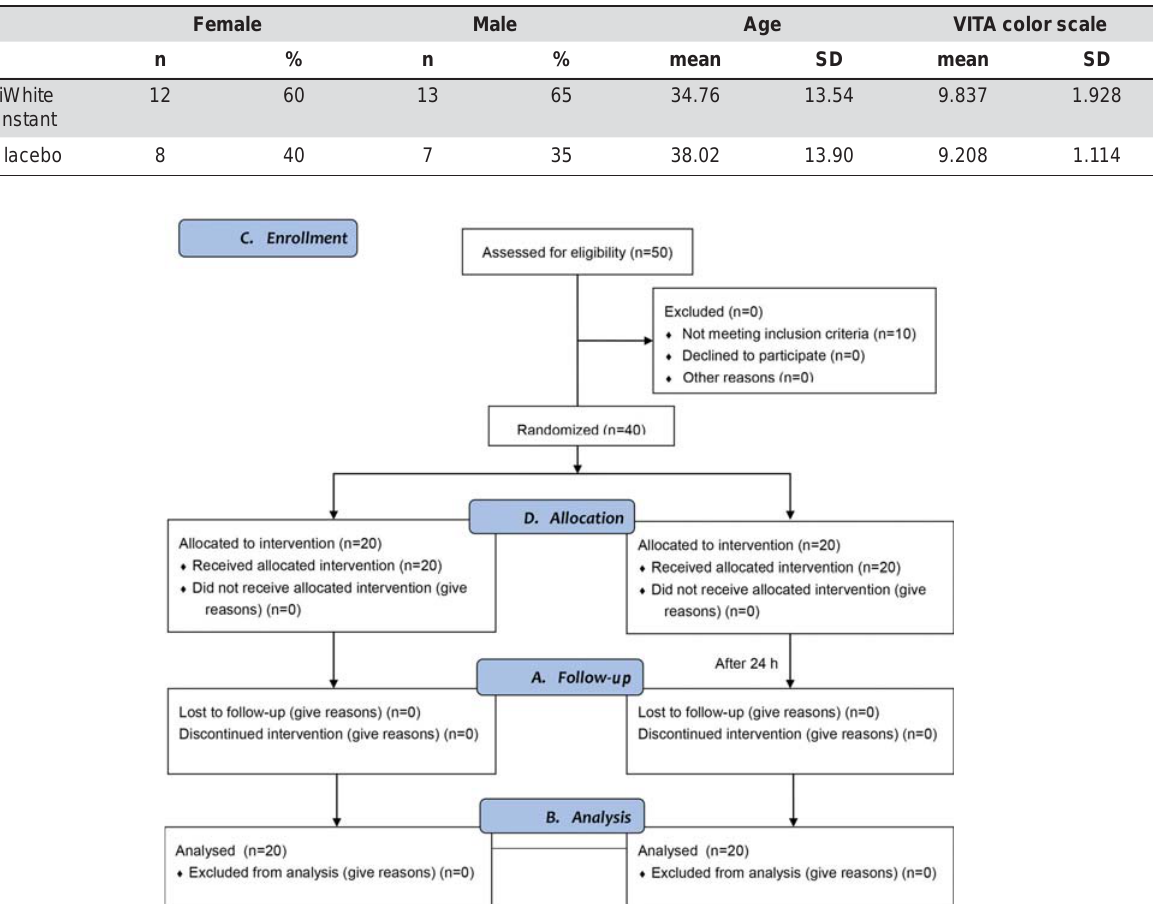
Table 1- Distribution of subjects by gender, age, and VITA color scale at baseline examination